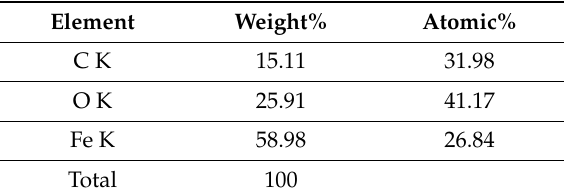
Figure 1. SEM images of ( a ) Fe 3 O 4 spheres and ( b ) Fe 3 O 4 /POA core-shell spheres. Table 1. EDAX data of Fe 3 O 4 spheres.